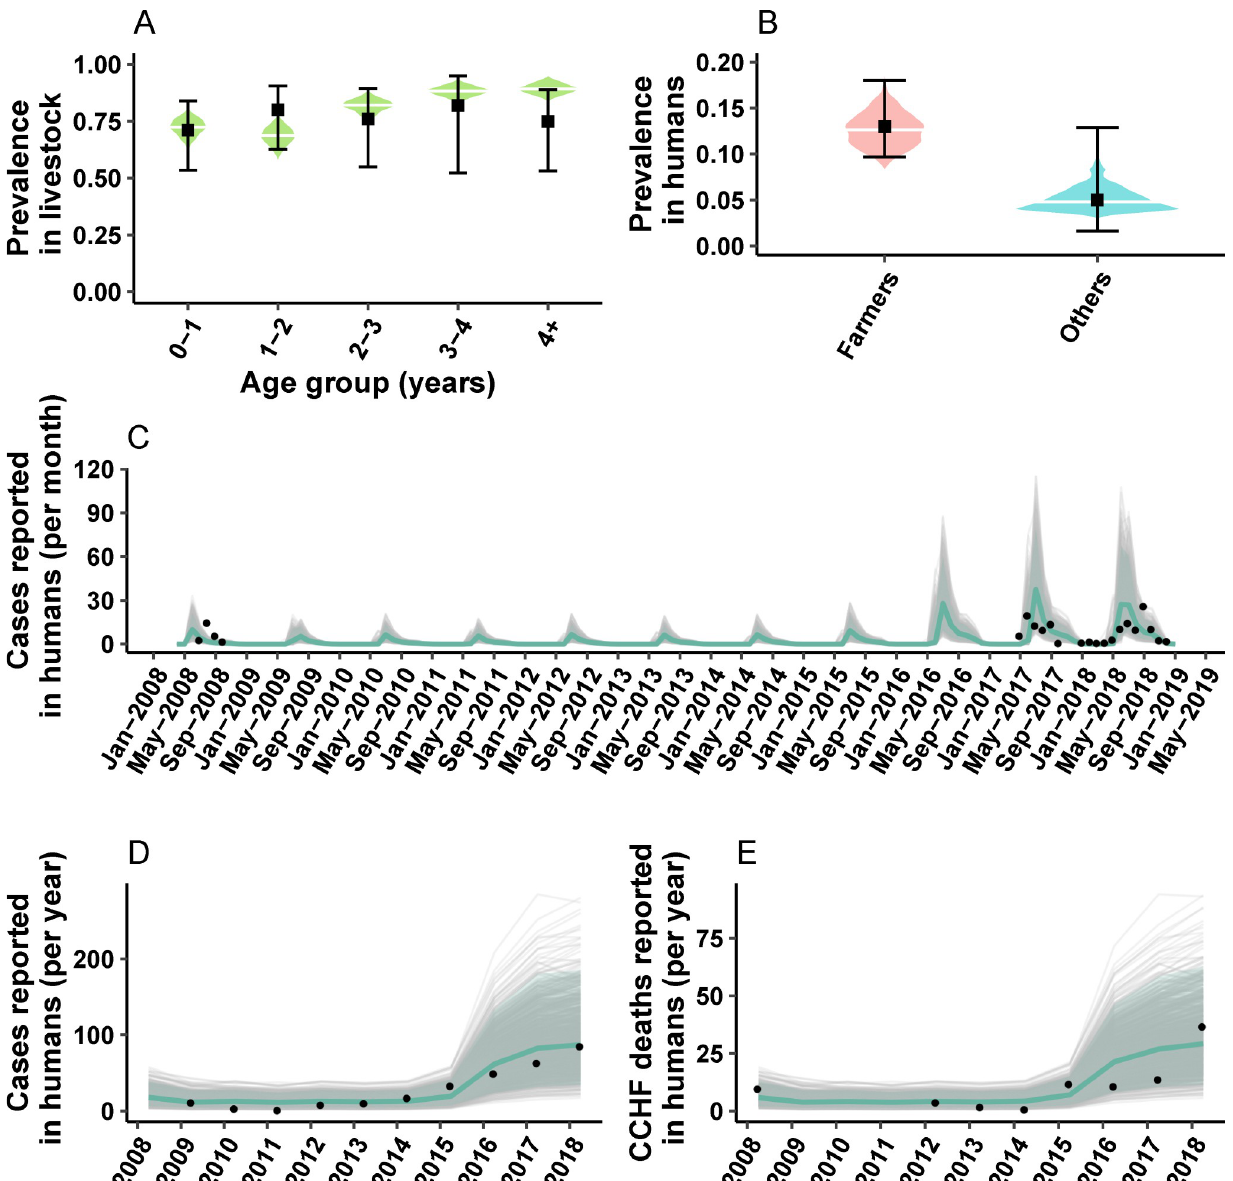
Fig 2. Model trajectories against calibration target data. (A) Simulated age stratified CCHFV prevalence among livestock (green density plot), with the median estimate (white horizontal line), against IgG prevalence data for the same age groups as reported by Mustafa et al [17] from Herat (black square shows the mean and error bars the 95%CI). (B) Posterior density and median estimate of IgG prevalence for the population of farmers and other occupations (density plots pink and blue) against IgG prevalence data from Herat reported. We take the prevalence estimate to match the dates of data collection as reported by Mustafa et al. (C) Stochastic model trajectories (grey lines) for monthly incident CCHFV human cases reported in Herat. In shaded pale grey, the 95% CrI and in solid blue, the median estimate. In black dots, monthly incident cases reported in two separate CCHF outbreaks in Herat: in 2008 as reported by Mofleh et al [15], and 2017–2018 as reported by Niazi et al, and Sahak et al [13,16].(D) & (E) yearly CCHF cases and deaths reported from Herat, against data (black) as reported by Sahak et al, respectively.